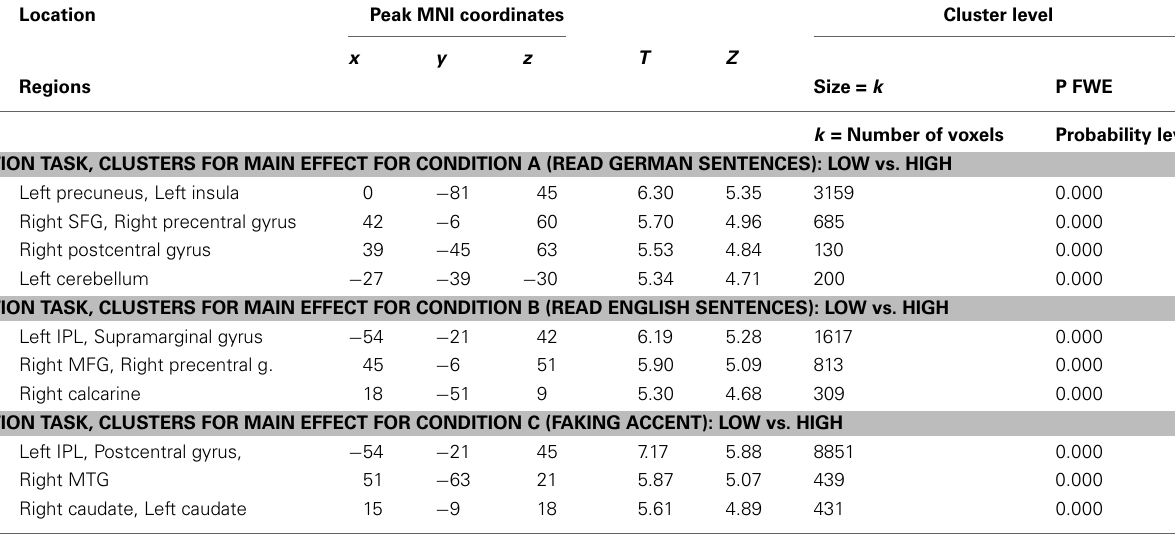
Table 2 | Table of the regions involved in the reading task for which the details of activations are provided in Table 1. Tag Location